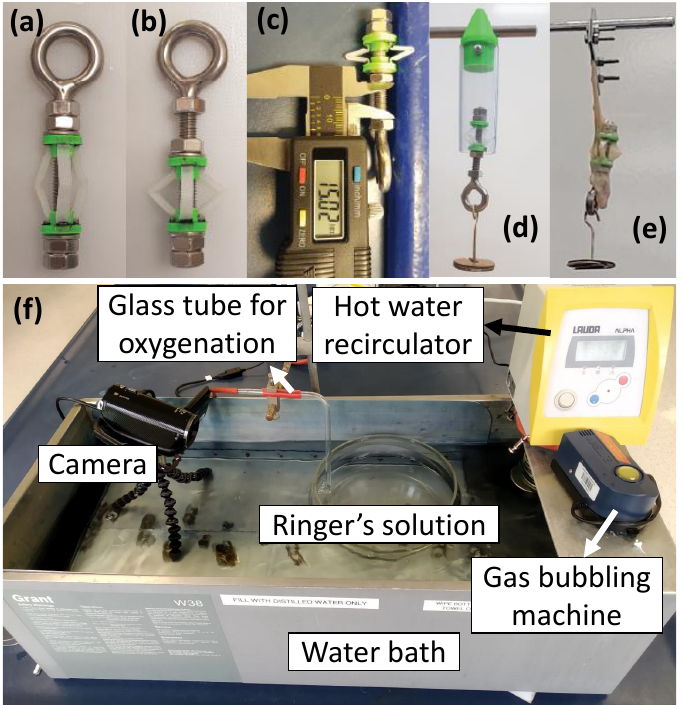
Figure 8. ( a – e ) Structural support to simulate compression of end caps for the anchoring mecha- nism. ( a ) Anchor mounted on support. ( b ) Anchor compressed by adjusting the support. ( c ) Fully compressed anchor with 15 mm displacement. Experimental setup for preliminary trials using ( d ) a vinyl tube and ( e ) ex vivo intestine. ( f ) In vitro experimental setup for maintaining the peristaltic movements of a freshly dissected